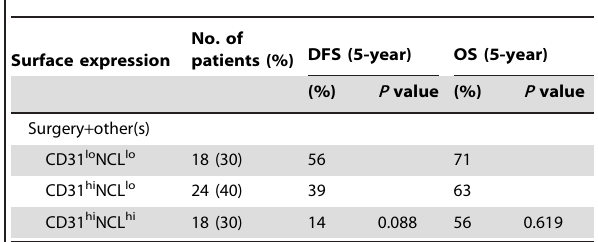
Table 2. Univariate analyses of DFS and OS according to the expression of CD31 and nucleolin in all patients and subgroups with clinicopathologic variables (Log-rank test).